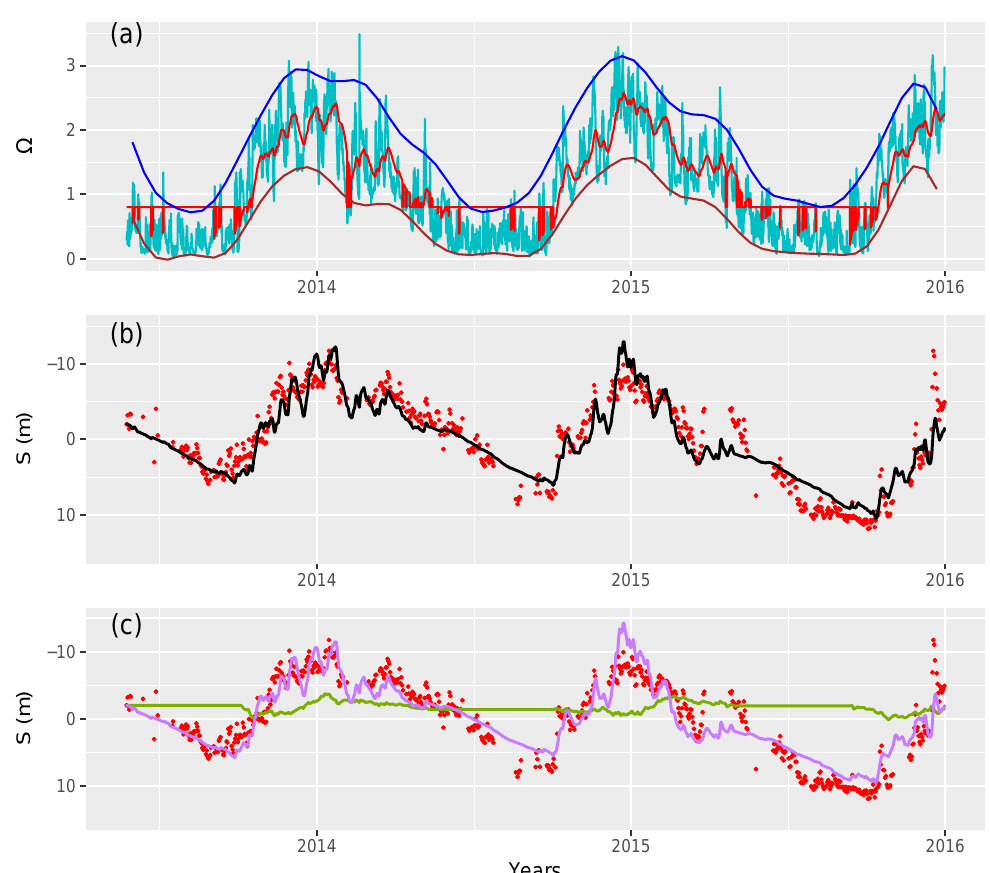
Figure 11. The combined model calibrated with DS 2 and modified equilibrium Dean number in summer. ( a ) Time series of Ω (light-blue line), Ω eq (red line), upper envelope (blue line), lower envelope (brown line). ( b ) Time series of measured shoreline position (red points) and modeled shoreline position (black line). ( c ) Time series of the longshore contribution (green line) and the cross-shore contribution (purple